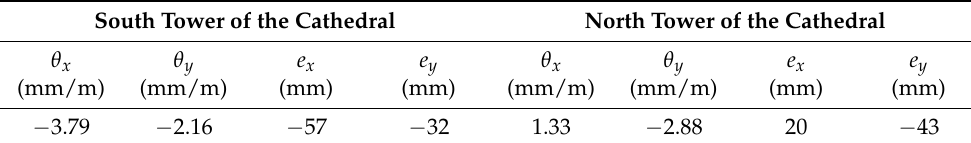
Table 1. Measured eccentricities of the towers e x and e y .